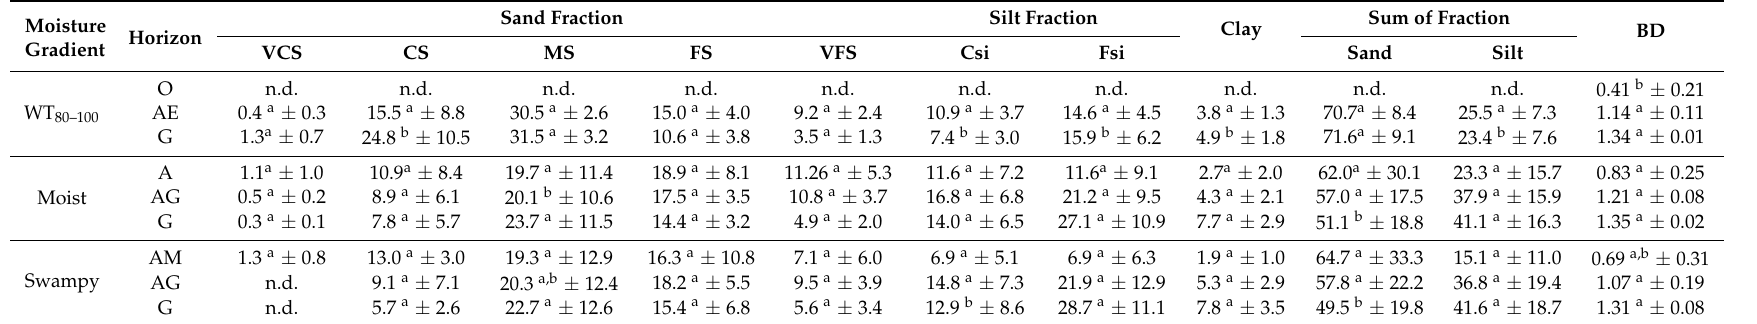
Table 3. The particle size [%] and bulk density [g · cm − 3 ] of study soils.